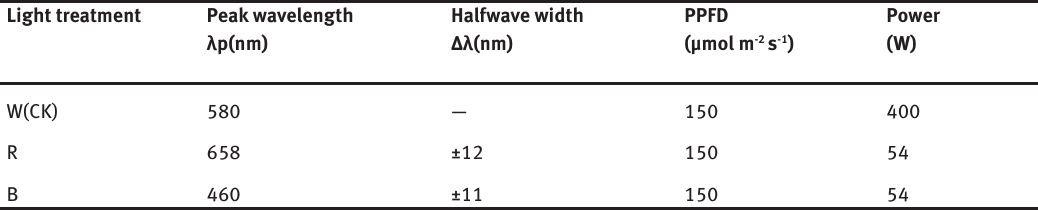
Table 1: Major technique parameters of different light spectral energy distribution. Light